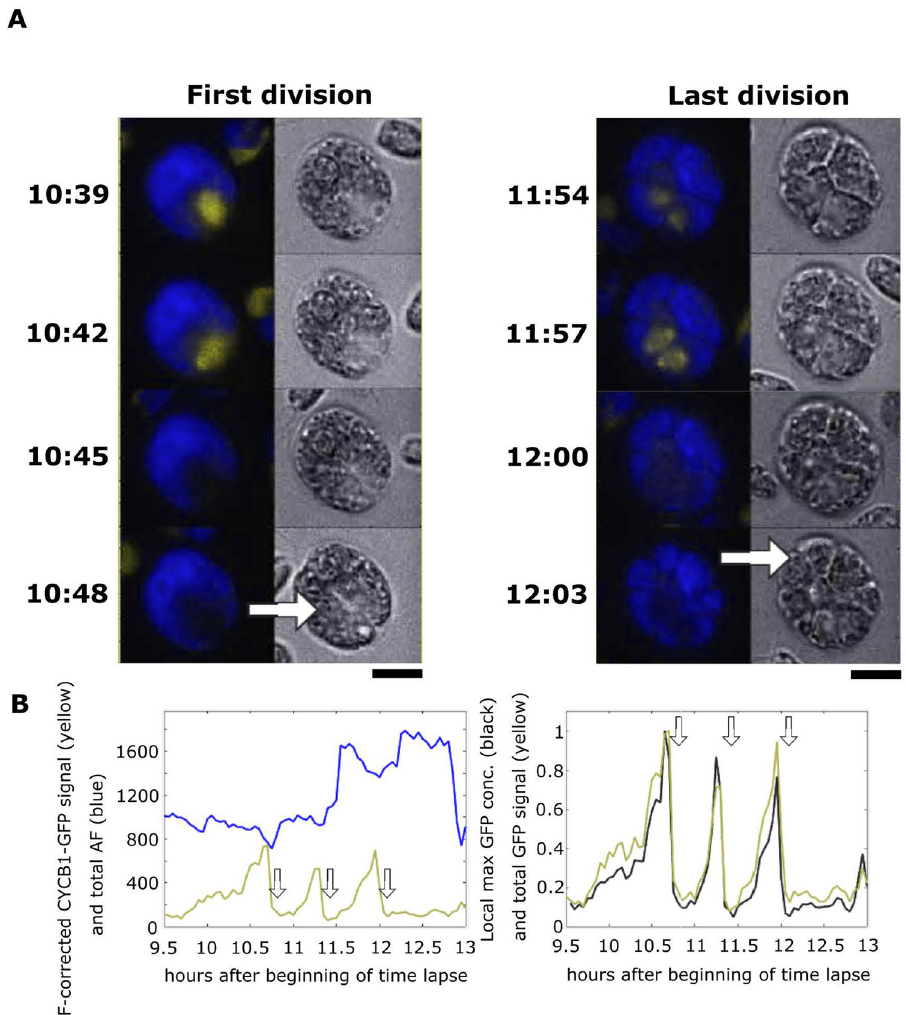
Fig 2. Live cell time-lapse microscopy of CYCB1-GFP. (A) Time-lapse images of CYCB1-GFP cells. Each cell has a brightfield image (right), and a composite of chloroplast autofluorescence in blue and CYCB1-GFP signal in yellow (left). Time indicated on top of each strip is hours and minutes after beginning of time-lapse. The indicated time corresponds to the top cell in each strip; cells below show the 3 min time-lapse series. Arrows indicate new cleavage furrow formation detected in brightfield. The imaged cell went through three divisions; frames surrounding the first and last divisions are shown. Scale bar: 5 microns. (B) Left: quantification of CYCB1-GFP signal deconvolved from chloroplast autofluorescence (yellow line), and chloroplast autofluorescence (blue line). Arrows: correspond to cleavage furrow formation. Right: Yellow trace: CYCB1-GFP total signal over the cell. Black: a minimal convex hull was computed that contained 50% of the CYCB1-GFP signal, and the concentration (signal/area) computed, showing that local concentration (probably within the nucleus; see text) and total cellular amount of CYCB1-GFP tracked closely through divisions. MATLAB code for calculating the convex hull available on